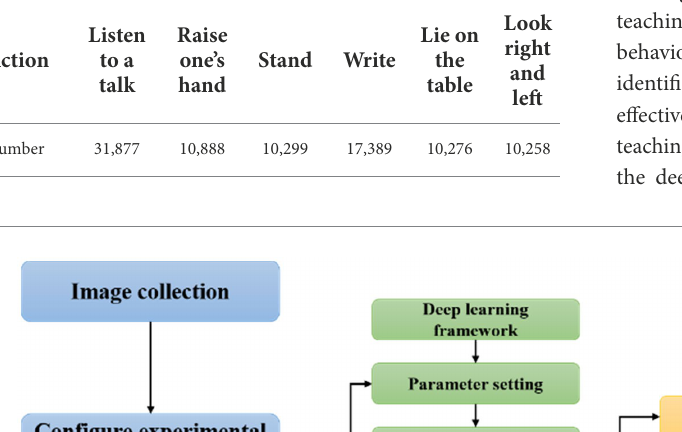
TABLE 5 The amount of image data of each behavior category after the data enhancement.